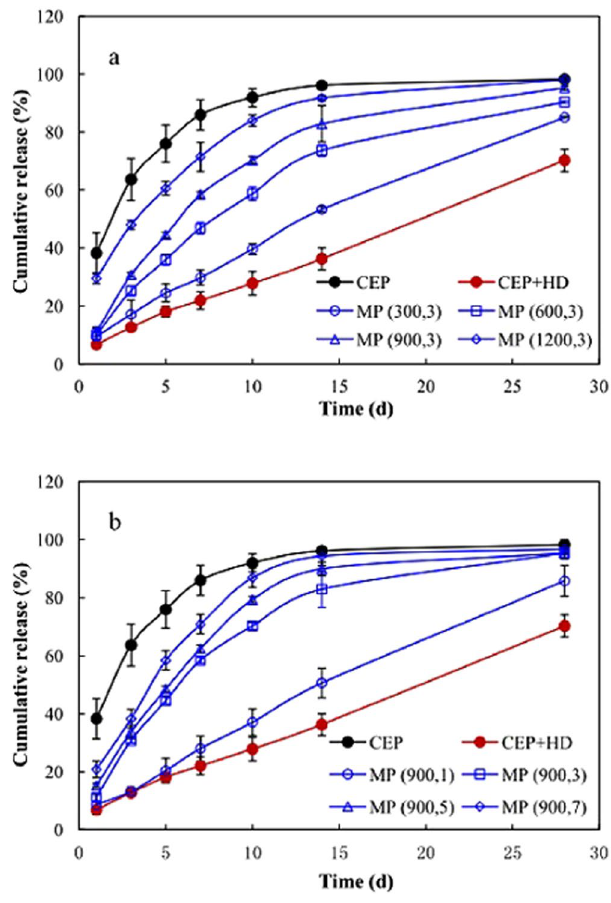
Figure 3. Nutrient release profiles of CRU prepared via CEP, CEP + HD and MP under different homogenizer pressure ( a ) and pass number ( b ). CEP denotes conventional emulsion polymerization, CEP + HD represents the emulsion containing HD synthesized by CEP, MP (m, n) signifies